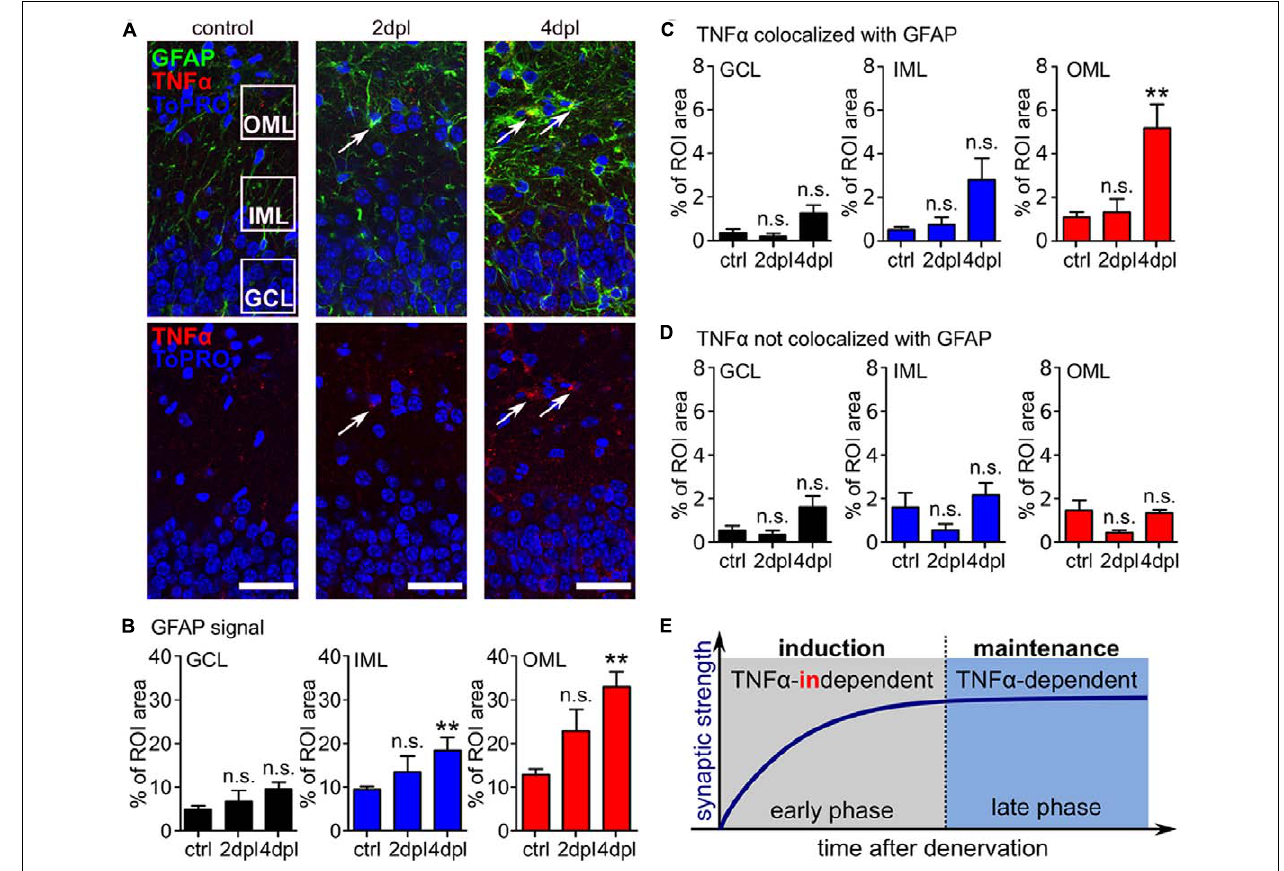
TNF α signal, which was colocalized with GFAP was significantly increased in the OML at 4 dpl (C, D) , suggesting that GFAP-positive astrocytes are a major source of TNF α following entorhinal denervation in vitro ( n = 6–8 cultures per group). Data represent mean ± SEM; ** p < 0.01; *** p < 0.001; n.s., not significant. (E) Entorhinal denervation in vitro reveals that denervation-induced homeostatic synaptic plasticity can